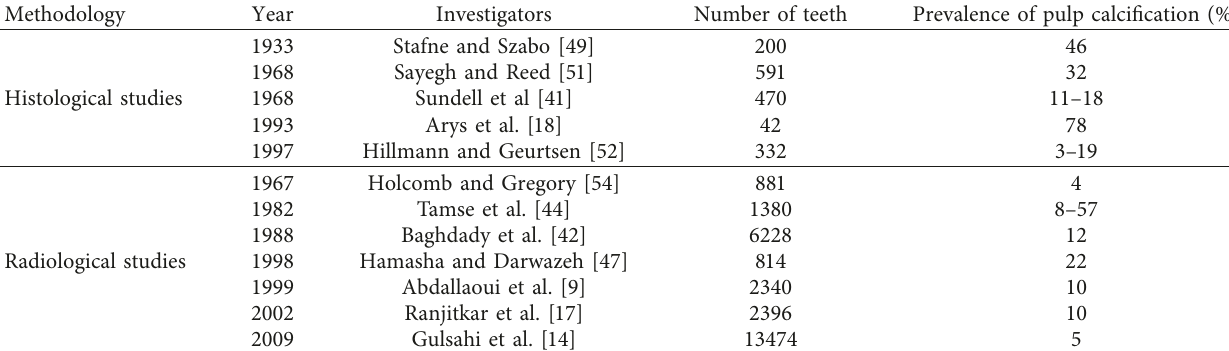
Table 5: Some previous studies on the prevalence (or incidence) of pulpal